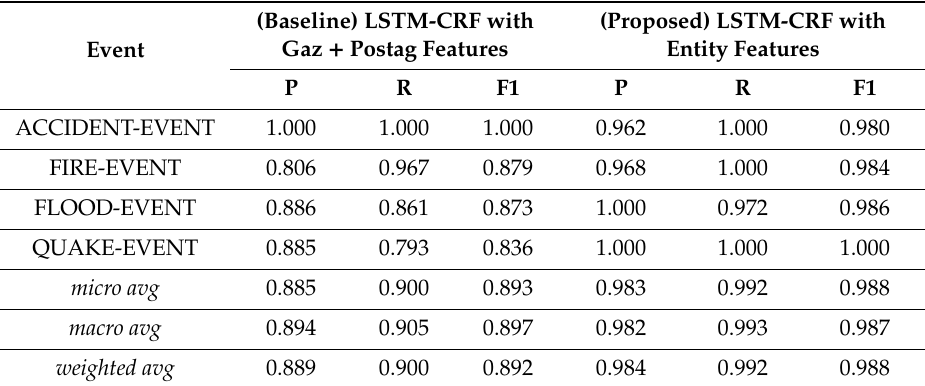
Table 7. Event trigger classification performance (step